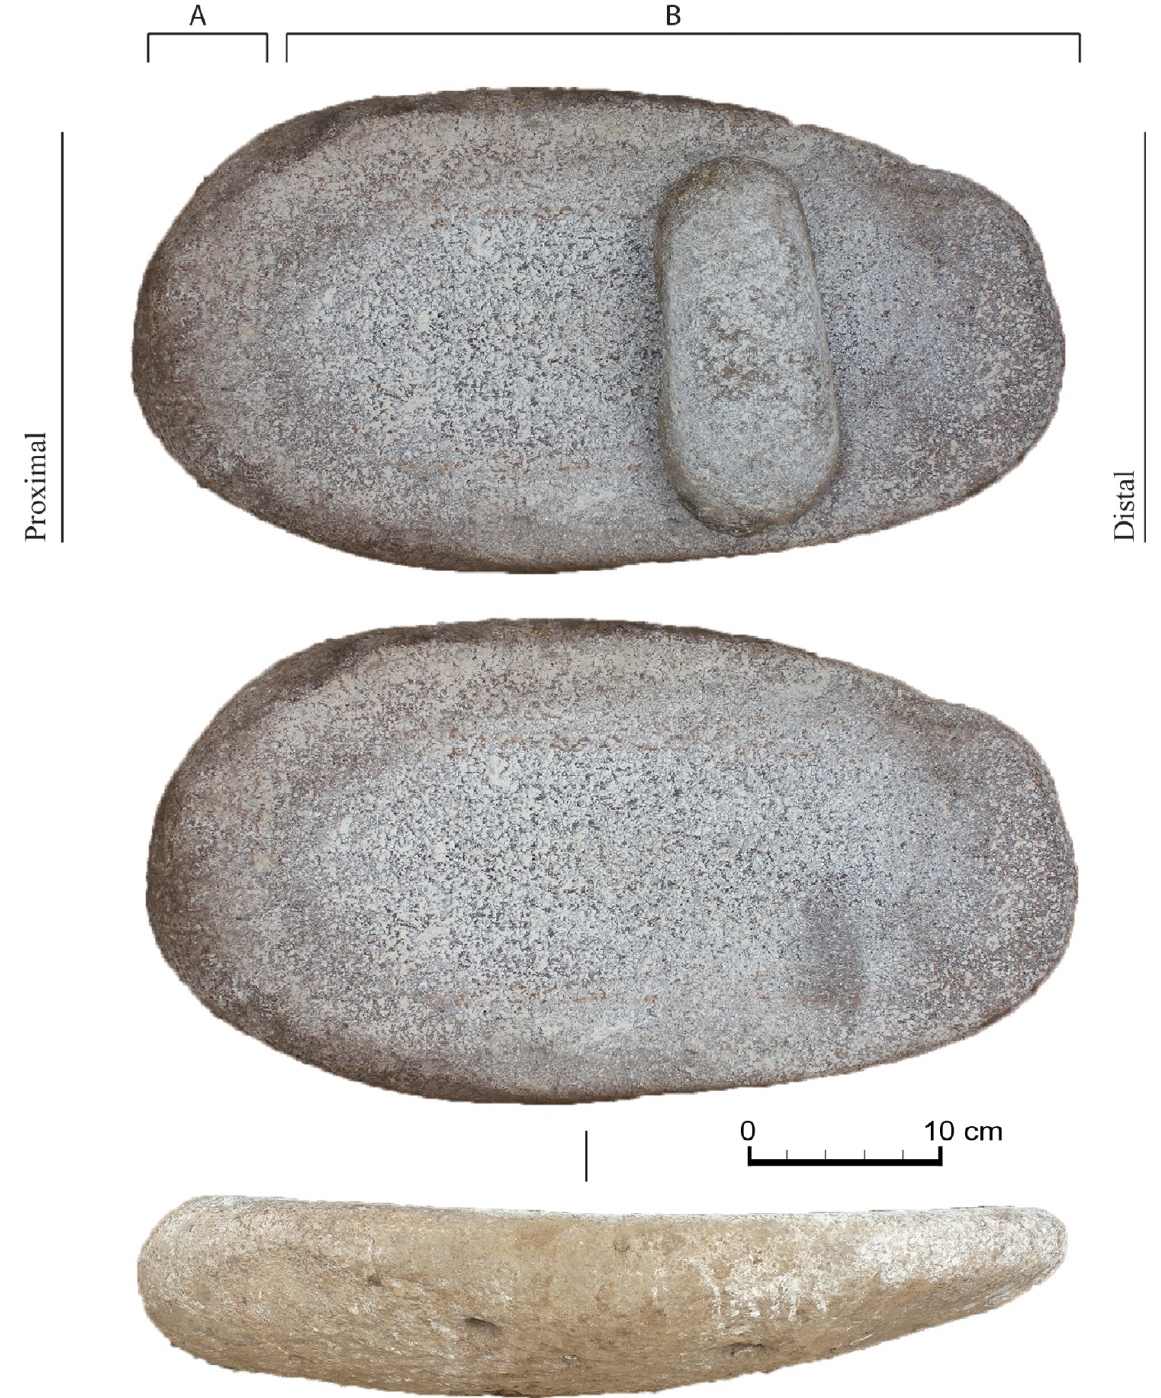
Figure 16. Typical morphology of a quern: Part A corresponds to the part where the grain is placed for milling. Part B corresponds to the active part of milling or crushing. The proximal part of the quern corresponds to the nearest part of the workers. The distal portion is the most remote part from the workers. Morphology oblong in plan; longitudinal and cross section are semi-circular. The proximal portion is thicker than the distal portion. Dimensions: Quern: L. 58 cm; w. 31 cm; h. 10.5 cm; Handstone: L. 23 cm; w. 11 cm; h. 6